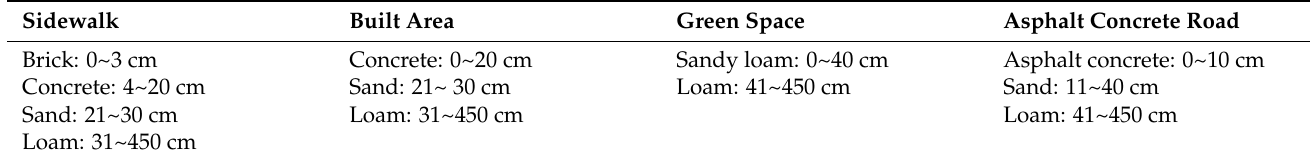
Table 2. Composition and depth in the ground profiles in ENVI-met.